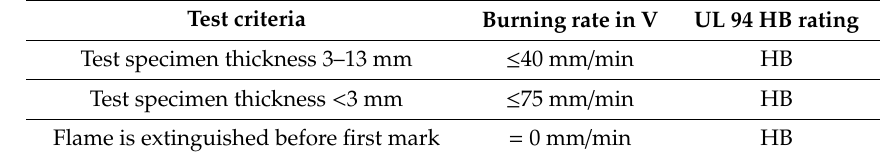
Table 3. Burning criteria for UL-94 horizontal